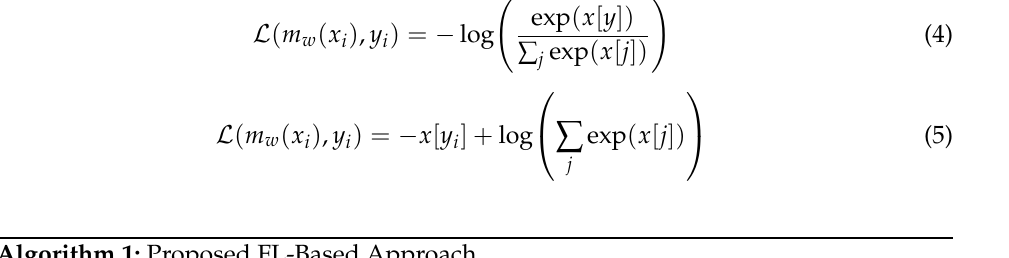
Algorithm 1: Proposed FL-Based